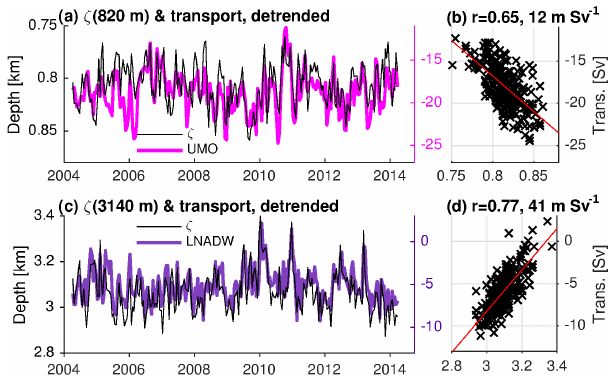
Figure 9. Time series of deseasonalized, detrended transports and isopycnal depths. (a) UMO transport (magenta) and the depth of the density surface with mean position at 820m (highest correla- tion with UMO) at the west. (c) LNADW transport (purple) and the depth of the density surface with highest correlation (at 3140m). Scatter plots are shown in (b, d) , where the least-squares linear re- gression is